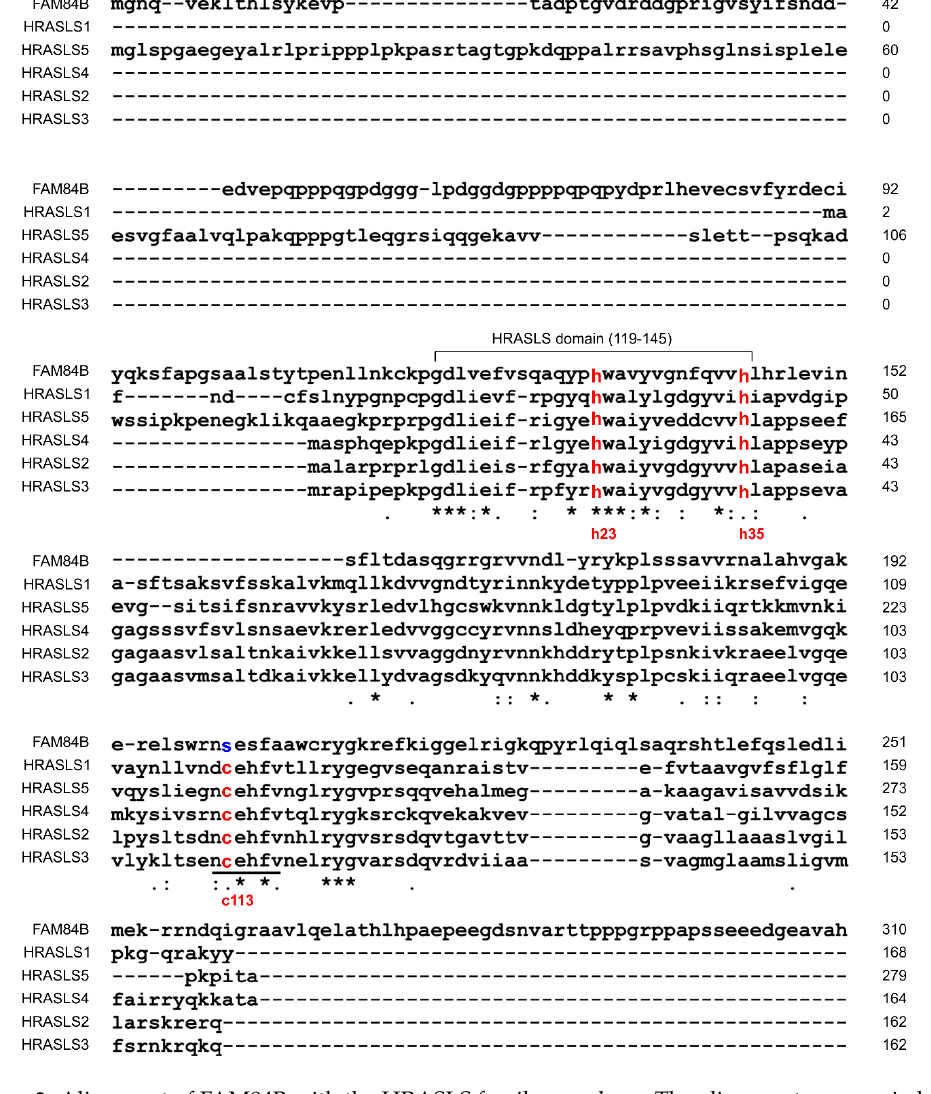
Figure 3. Alignment of FAM84B with the HRASLS family members. The alignment was carried out using CLUSTAL 2.1 Multiple Sequence Alignments. The three active residues (histidine 23/H23, H35, and cysteine 113/C113) are numbered based on HRASLS2 and are indicated (red). The highly conserved residues NCEHFV in HRASLS1-5 are underlined. The FAM84B fragment containing residues 119–145, which shows high homology with HRASLS1-5, is defined as HRASLS domain (119–145).